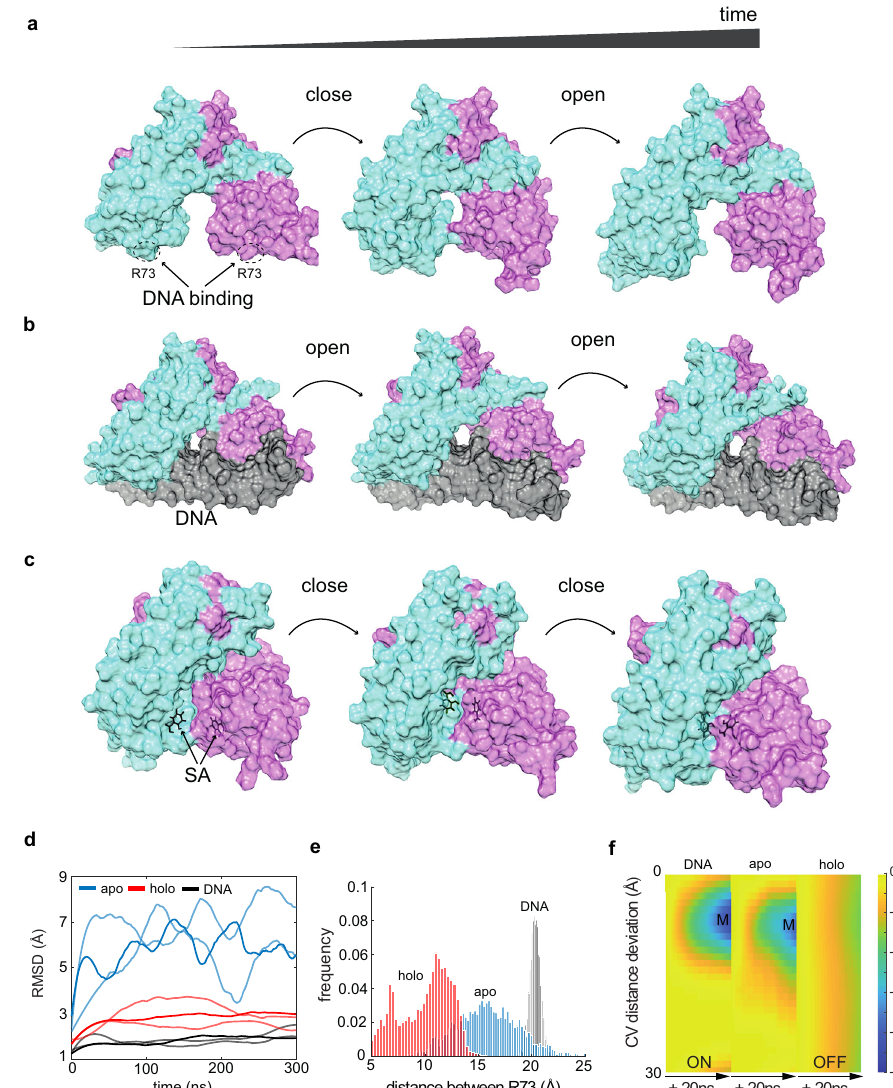
Fig. 2 On – OFF states underlies the chemical sensing by Mar receptors. a – c Time-lapse from MD simulations of the fl exible MarR apoprotein (monomers are shown in cyan and purple) ( a ) display a cyclic change of conformation states (open – closed – open). MarR dimer bound to DNA operator site (black) remains in the open conformation with a speci fi c distance of ~20 A ̊ between DNA contacting R73 ( b ). MarR bound to two molecules of SA(black) ( c ) display successive shortening of the distance between R73 that re fl ects an unbinding of MarR from DNA. d Time-traces of molecular dynamics simulations with MarR apo (blue), MarR holo (red), and DNA-bound MarR (black) (3 independent replicates are shown per modeled system). The root-mean-square deviation of atomic positions (RMSD) is shown for dimer simulations of 300 ns. Note, the cyclic pattern of closed-to-open conformation of MarR apo which was absent from MarR holo simulations as holoprotein stabilizes in the closed conformation. In contrast, DNA-bound MarR retains an open con fi rmation. e A probability distribution of the mean distance between R73 atoms of both monomers (from all three replicates) for apo (blue), holo(red), and DNA-bound (black) con fi gurations. Note that the holo state provides a = 2-fold short distance between DBD domains than that required for a stable bond with DNA. f Energy landscapes for three MarR con fi gurations (apo, holo, DNA-bound) for deviation from the preferred distance of ≈ 20 A ̊ between R73 (both chains) required for DNA binding. Note energy minima wells (M, blue) for apo and DNA bound con fi gurations which were absent in holoprotein simulations indicating that the ligand-bound MarR did not reach an energy minimum required for the association with the DNA con fi